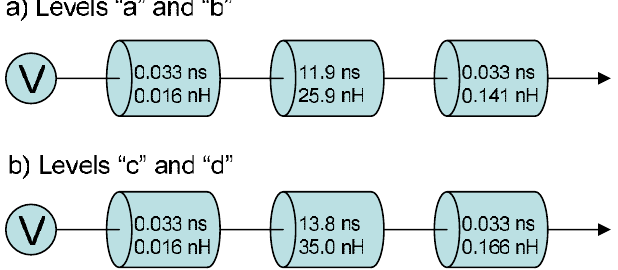
FIG. 10. (Color) Transmission-line models used to drive the four wave boundary inputs for the 2-cm radius load simulations. The voltage waveform from Fig. 9 is input at the left and the arrow at the right indicates the connection to the simulation grid.